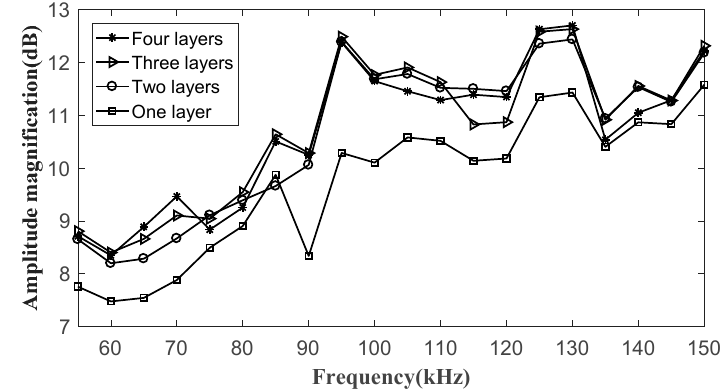
Figure 17. Amplitude magnification for the magnetostrictive patch transducer with different lift-off distances of the SMP at several typical frequencies. T1 was an actuator and sensor. 5. Conclusions A method of signal strength enhancement was proposed for the magnetostrictive patch transducer (MPT) by dynamic magnetic field optimization with a soft magnetic patch (SMP) in guided wave inspection. The enhancement was achieved by decreasing the resistance of the magnetic circuit in wave generation and restricting the induced dynamic magnetic field in wave detection. A numerical investigation was successfully performed for the improvement of dynamic magnetic fields in the magnetostrictive patch and region around the coils. Experimental validation was carried out for the SH0 wave inspection in an aluminum plate. The main findings are summarized as follows: 1.